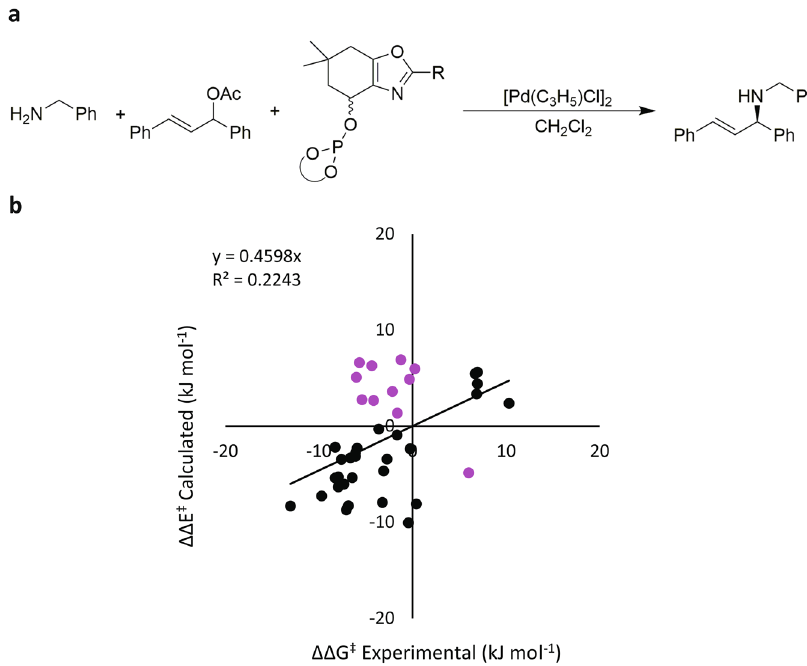
Fig. 3 Comparison of relative energies of the experimental values to the calculated MM values for 39 phosphite-oxazole ligands. a Reaction corresponding to the 11 mismatched data points. b Calculated vs. experimental stereoselectivity with mismatched cases in